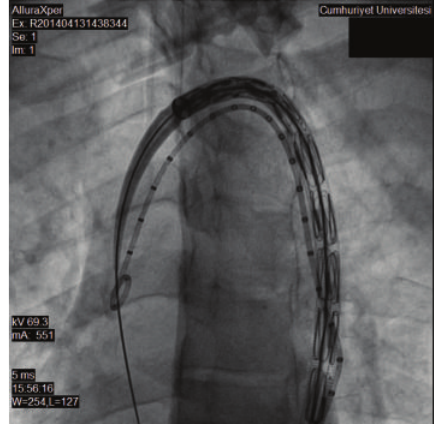
Figure 4: Thoracic stent graft was placed across the coarcted segment.